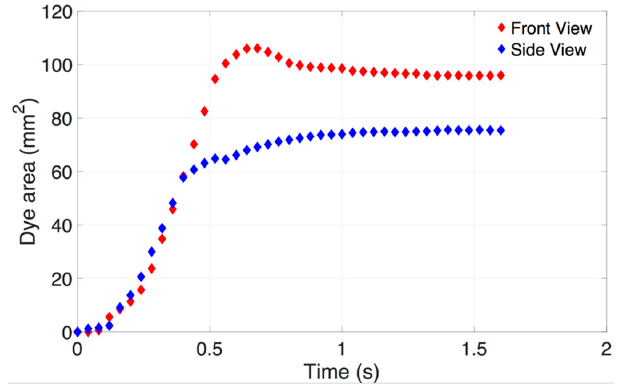
Figure 10. Evolution of dye area against time in the case of fast injections ( Re = 589) into the HA vitreous (1.0 mg/mL). The dye area was measured from images taken from a digital SLR camera at 25 Hz, or every 40 ms. The dye area reached a maximum area of 106 mm 2 from the front view and 72 mm 2 from the side view. This indicates the bolus is not perfectly spherical in shape and this assumption should be avoided when modeling IVT in liquid-phase vitreous.